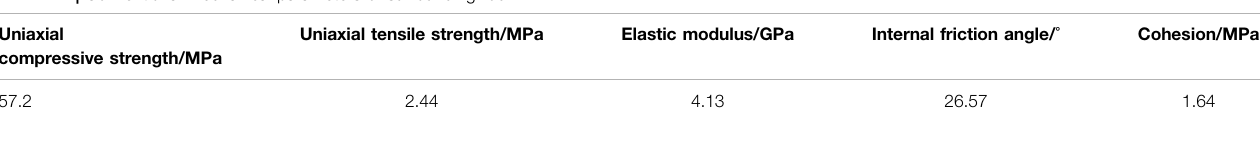
TABLE 2 | Conventional mechanical parameters of surrounding